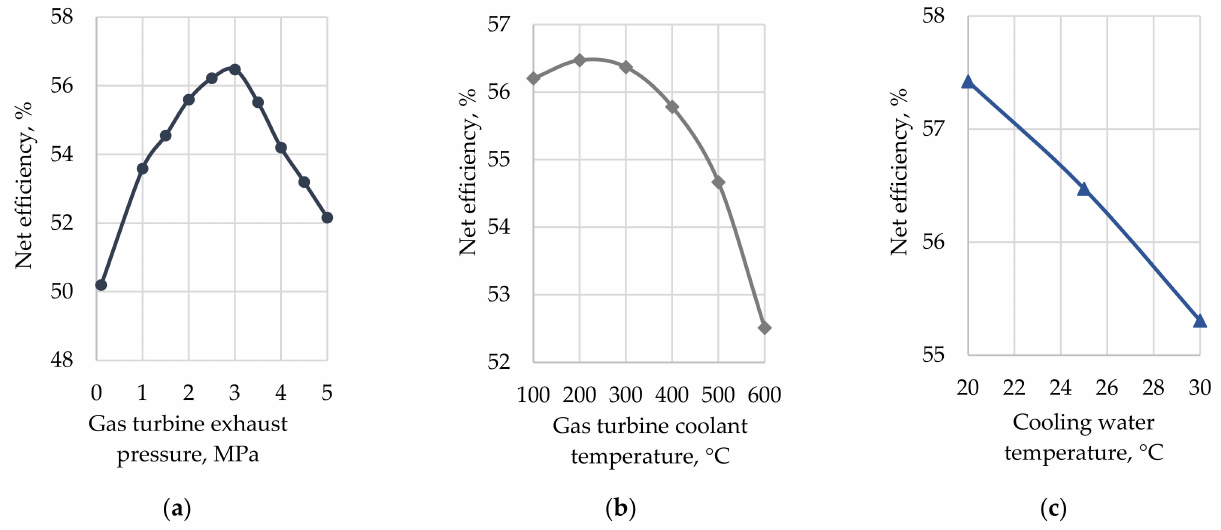
Figure 14. The Allam cycle parameters’ optimization at the initial parameters of 1083 ◦ C and 30 MPa: ( a ) gas turbine exhaust pressure optimization; ( b ) gas turbine coolant temperature optimization; ( c ) cooling water temperature